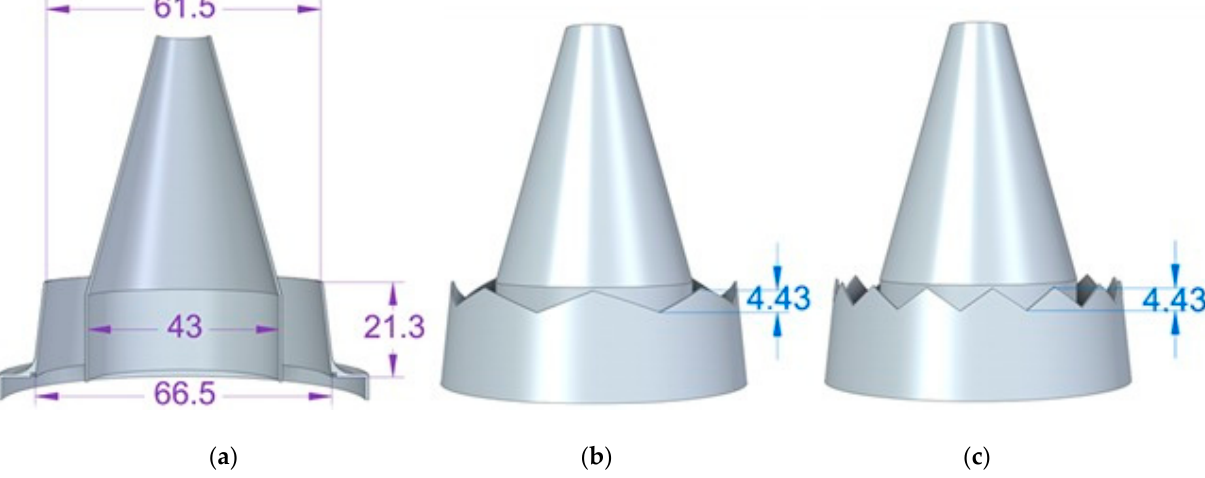
Figure 2. Nozzles 3D designed- perspective view: ( a ) 3D designed reference nozzle, ( b ) 3D designed N8 L10 I0 nozzle, ( c ) 3D designed N16 L10 I0 nozzle.